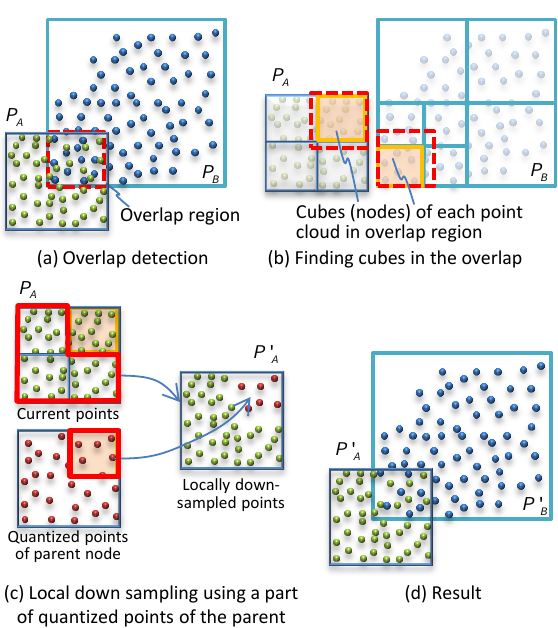
Figure 5. Rendering of multiple point clouds with